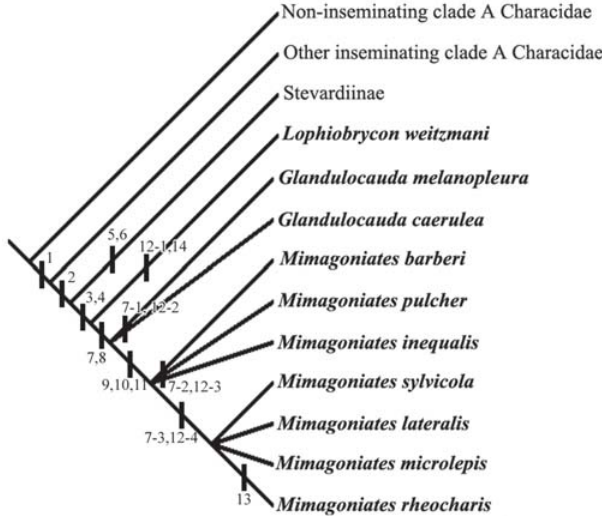
Fig. 2. Cladogram of the most parsimonious hypothesis showing the relationships of the genera and species of the Glandulocaudinae.